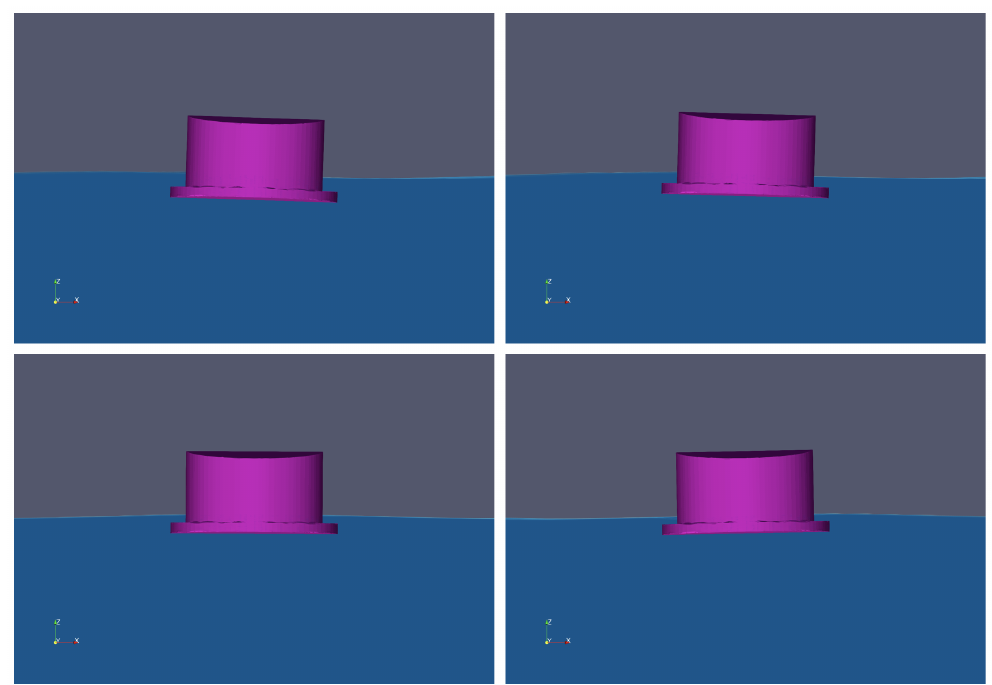
Figure 22. Snapshots of water and the floater H = 2.72 cm and T = 1.4 s, from t / T = 25.5 to 26.